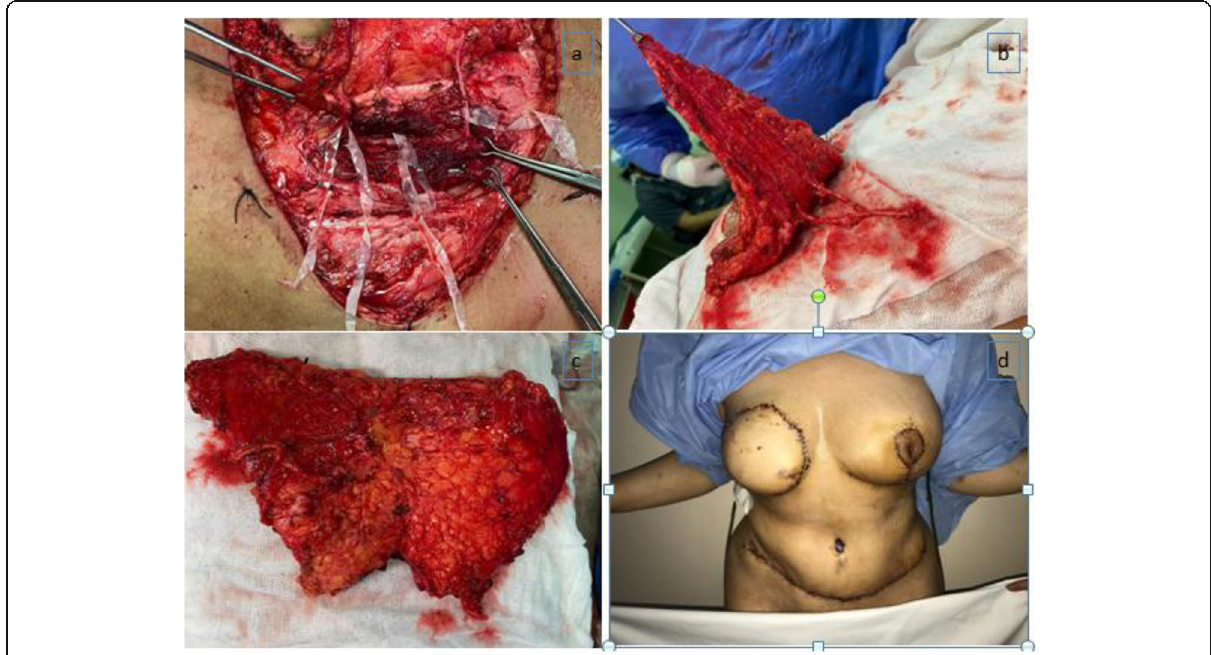
Fig. 6 The intra-operative perforator flap methodology: a elliptical incision through the lower abdominal adipocutaneous tissue to delineate the origins of the perforators from the deep inferior epigastric artery, b , c dominant perforator artery identified and dissected with mobilization of the flap ( d ) reconstructed breast after anastomosis of the mobilized flap with the vessels at the recipient site. In addition, there is left nipple reconstruction noted